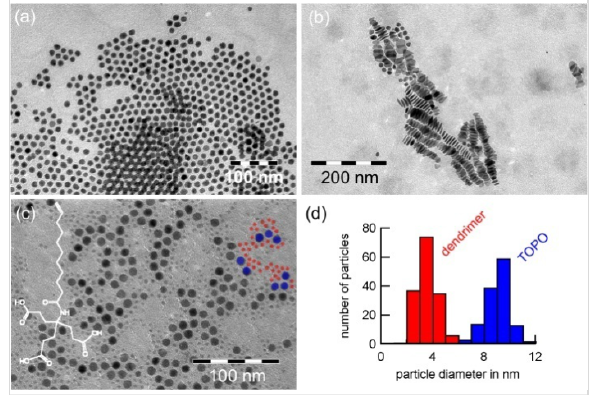
Figure 3: Transmission electron microscopy (TEM) images of Co parti- cles of various sizes and morphologies synthesized under the influ- ence of (a) TOPO, (b) oleic acid and oleylamine and (c) a dendrimer and TOPO which results in two distinct particle sizes (d). Such effects are shown in Figure 3: The subplots present parti- octacarbonyl as a precursor. As a ligand (a) TOPO, (b) a mix-